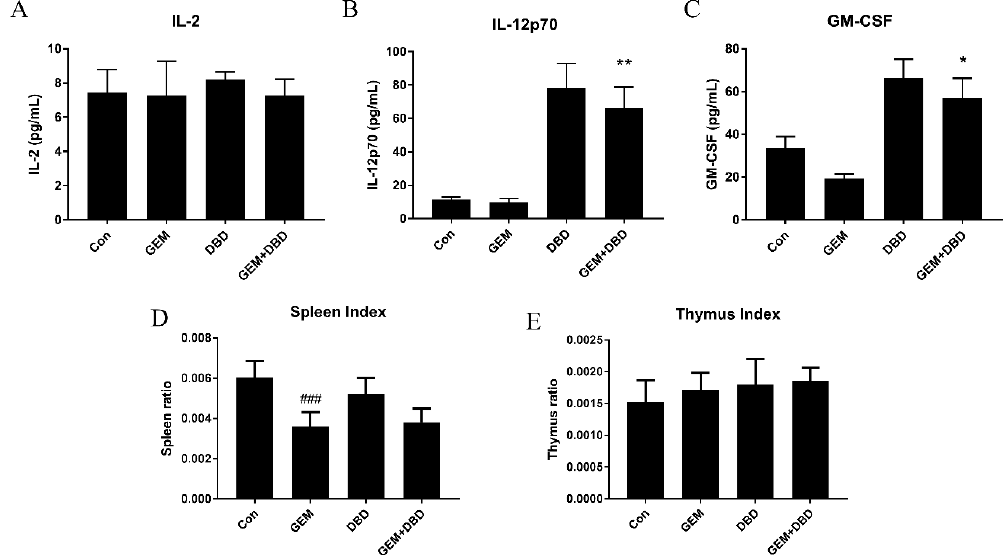
Figure 5. Immune regulatory effect of DBD on LLC-bearing mice. ELISA results showing IL-2 ( A ), IL-12 ( B ) and GM-CSF ( C ) expression in LLC tumor-bearing mice serum. ( D ) Spleen indexes and ( E ) Thymus indexes of tumor-bearing mice. Data were expressed as mean ± SEM ( n = 4 for A, B, and C. n = 10 for D and E). * p < 0.05, GEM + DBD versus GEM. ** p < 0.01, GEM + DBD versus GEM. ### p < 0.001, GEM versus Con.